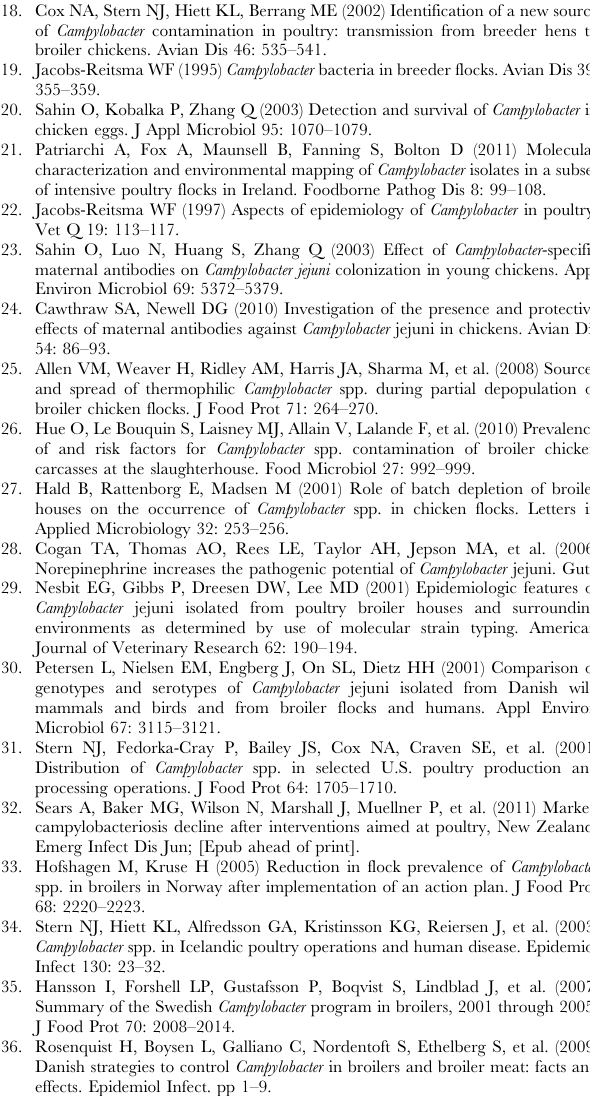
Figure 7. Comparison of flaA -SVR sequences of Campylobacter isolates from breeder and broiler farms and farm environments. A total of 101 isolates were included. Strain Campylobacter jejuni NCTC11168 was included as a control strain in the pairwise analysis. The arrow indicates the 98% similarity cut-off point. flaA , flaA -SVR allele number; ST, sequence type; CC, clonal complex; Nt, not tested; NA, not assigned; -, not